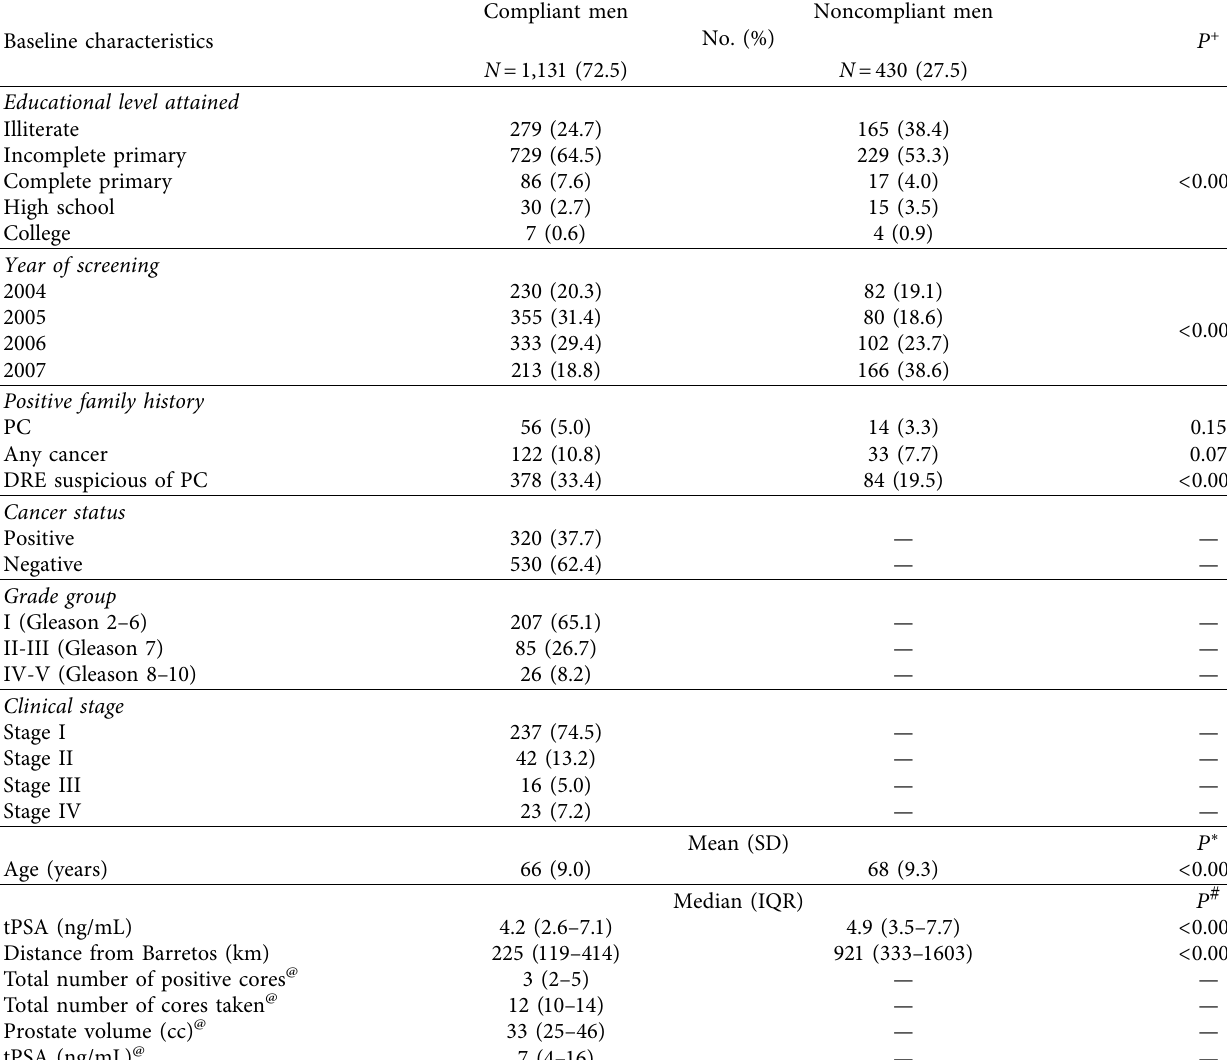
Table 1: Baseline characteristics of men undergoing initial PC screening by Brazilian mobile medical units stratified by compliance to biopsy